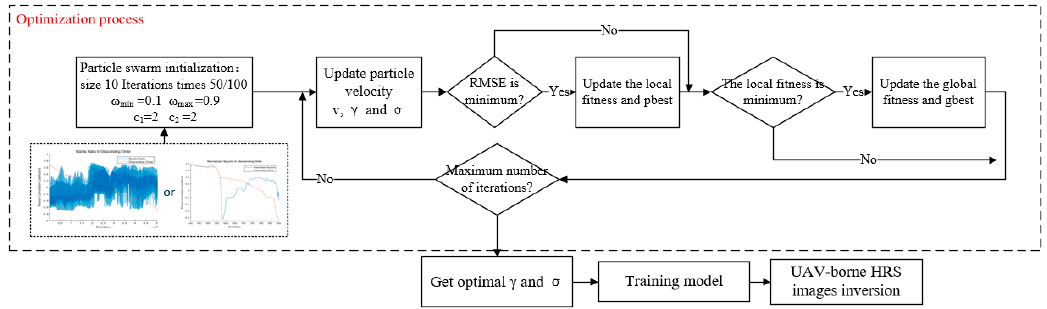
Figure 10. Flow diagram of PSO-LSSVM for the inversion of suspended solids concentration.